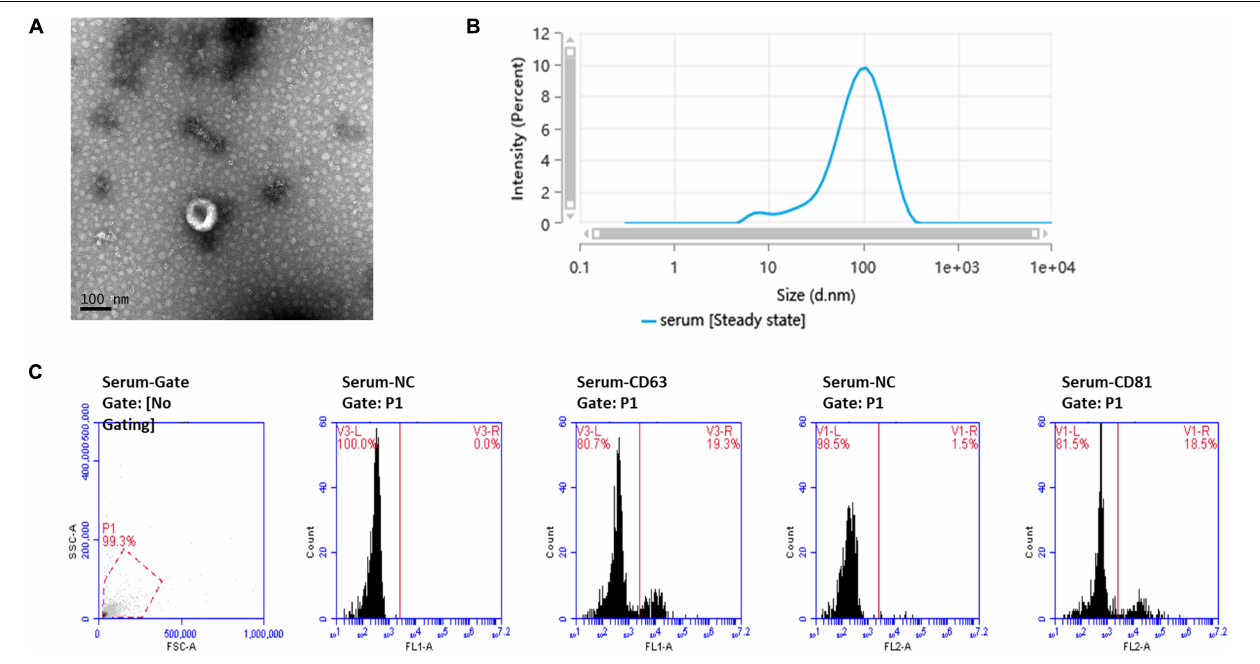
FIGURE 1 | Ultrastructure and characterization of serum-derived exosomes. (A) TEM image shows that the exosomes have a cup-shaped structure. Bar , 100 nm. (B) Of the particles, 89.026% were 20–200 nm in size, as detected by nanoparticle tracking analysis (NTA). (C) Flow cytometry analysis of the exosome markers CD63 and CD81, with 19.3 and 18.5% positive rates,